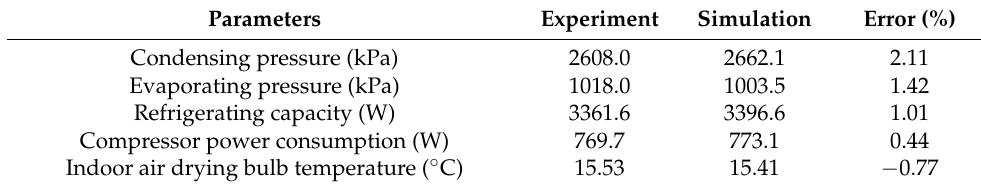
Table 2. Relative error of main parameters in air conditioning